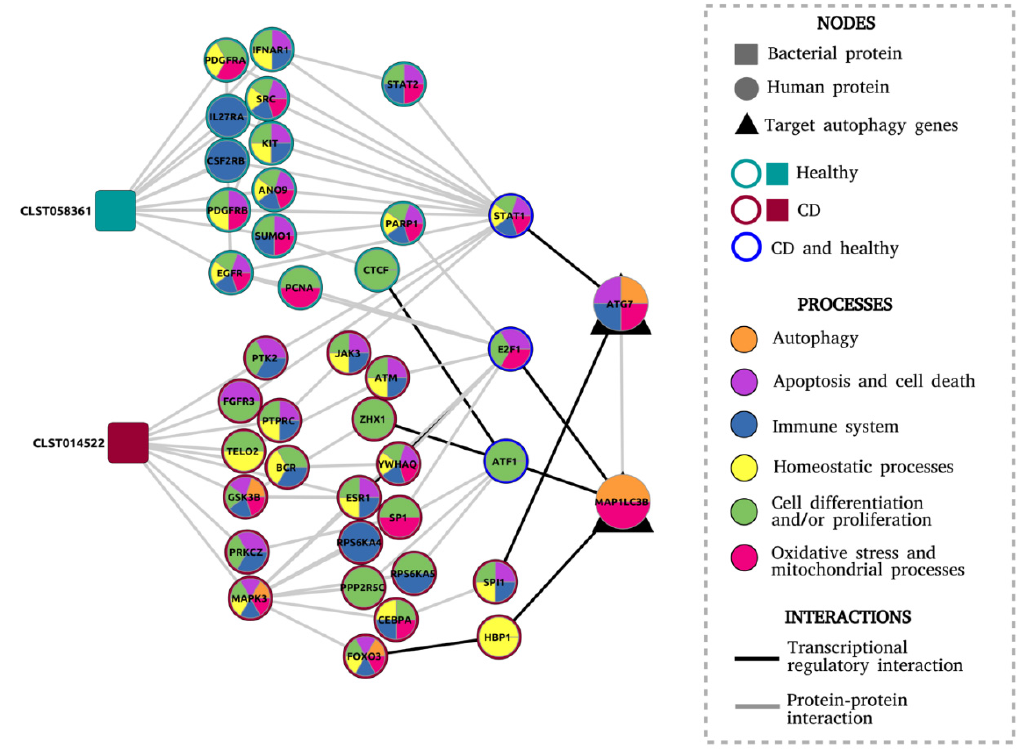
Figure 3. Final network model consisting of the proteins and the biological processes in which they are involved, inferred from the Gene Ontology (GO) enrichment test.